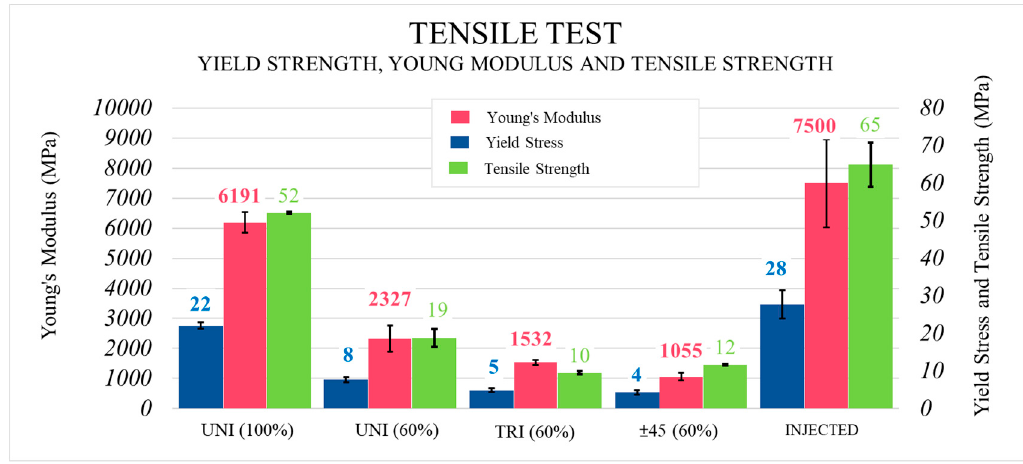
Figure 6. Tensile test. Results obtained for Young’s Modulus, yield strength and tensile strength of the injected and 3D printed samples.